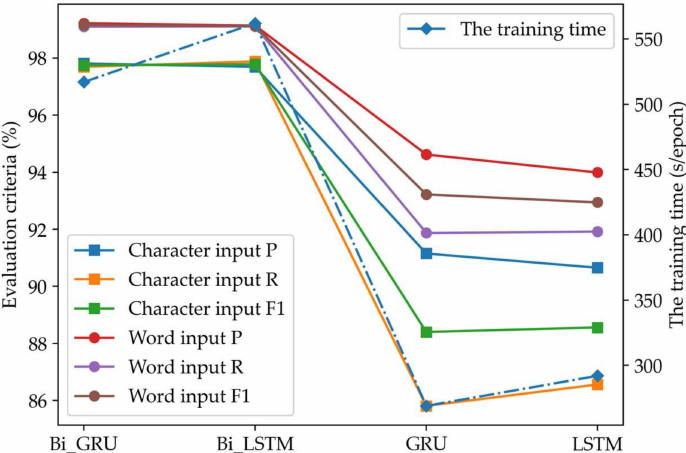
Figure 6. Segmentation results of each neural network for di ff erent input models. Precision (P), recall (R), and F1-score